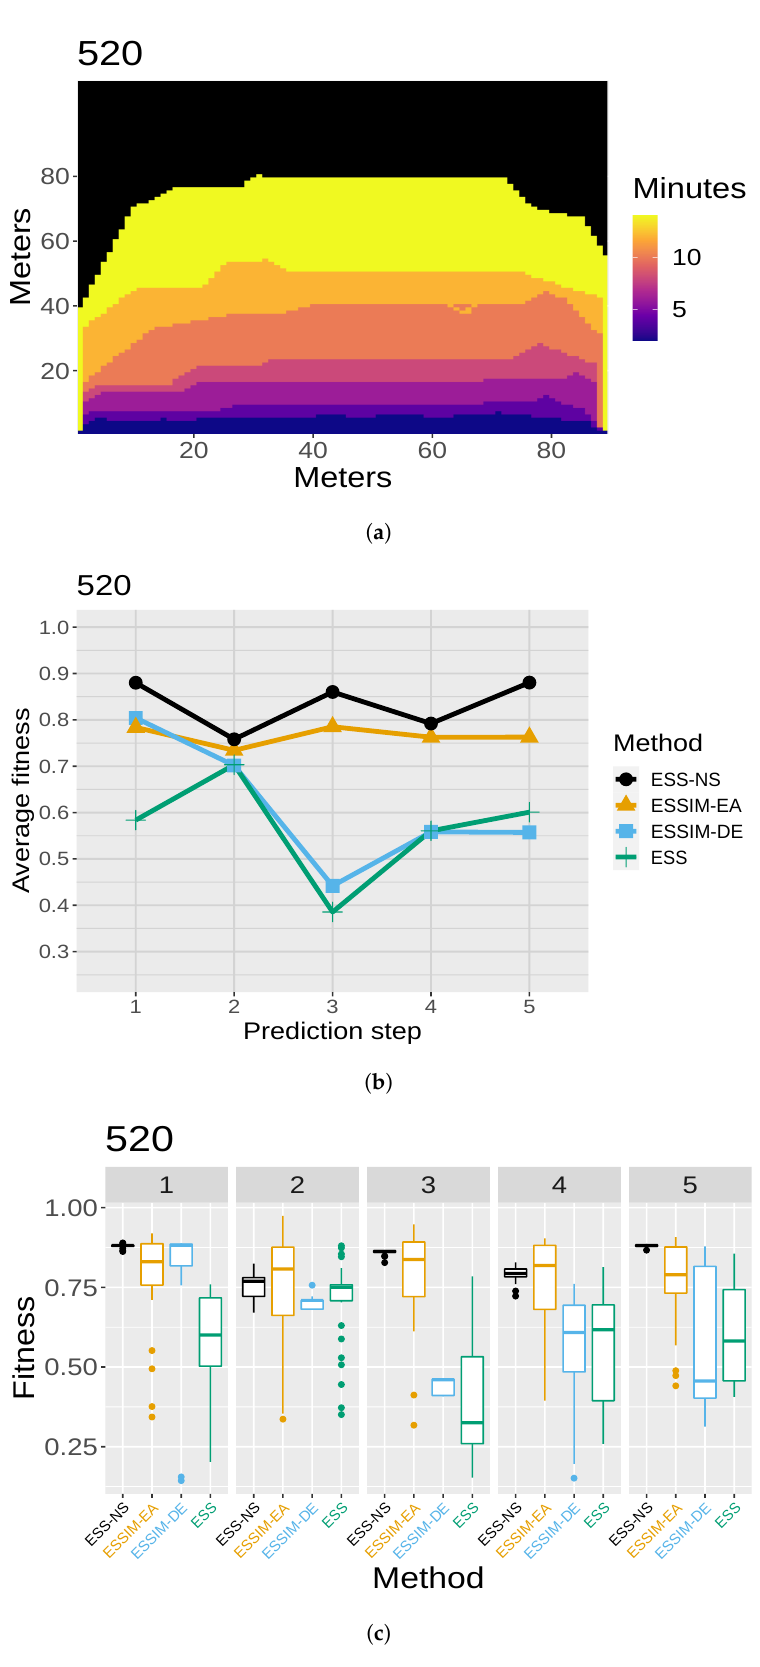
Figure 7. Case 520: ( a ) map of the real fire spread; ( b ) fitness averages; and ( c ) fitness